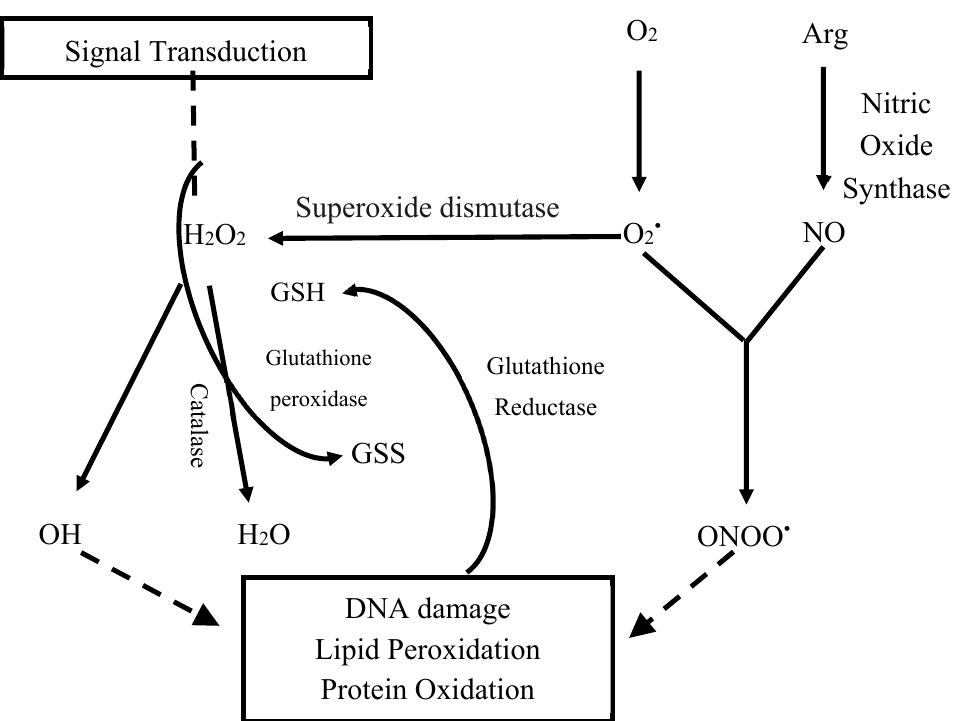
Figure 1. Reactive oxygen species (ROS) generation and effect in a cardiomyocyte. It begins with partial reduction of oxygen (O 2 ) to give superoxide (O 2• ), ultimately generating hydroxyl radical (OH • ). ONOO • (peroxynitrite), hydrogen peroxide (H 2 O 2 ), arginine (Arg), nitric oxide (NO), oxidised glutathione GSSG, reduced glutathione GSH, water (H 2 O).